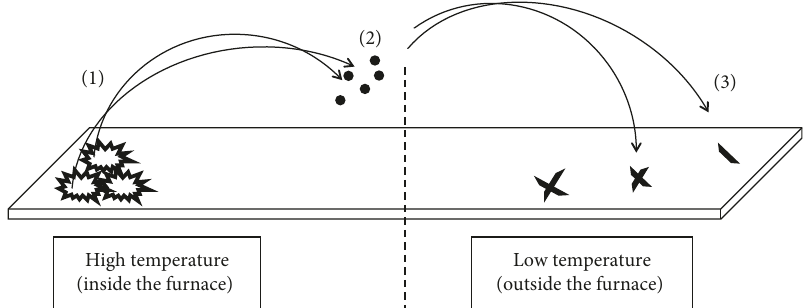
Figure 2: HVPG schematics: (1) source macromaterials placed at the end of the tube inside the furnace, (2) the materials changing to particles, and (3) the nanocomposite materials depositing on the parts of the tube outside the